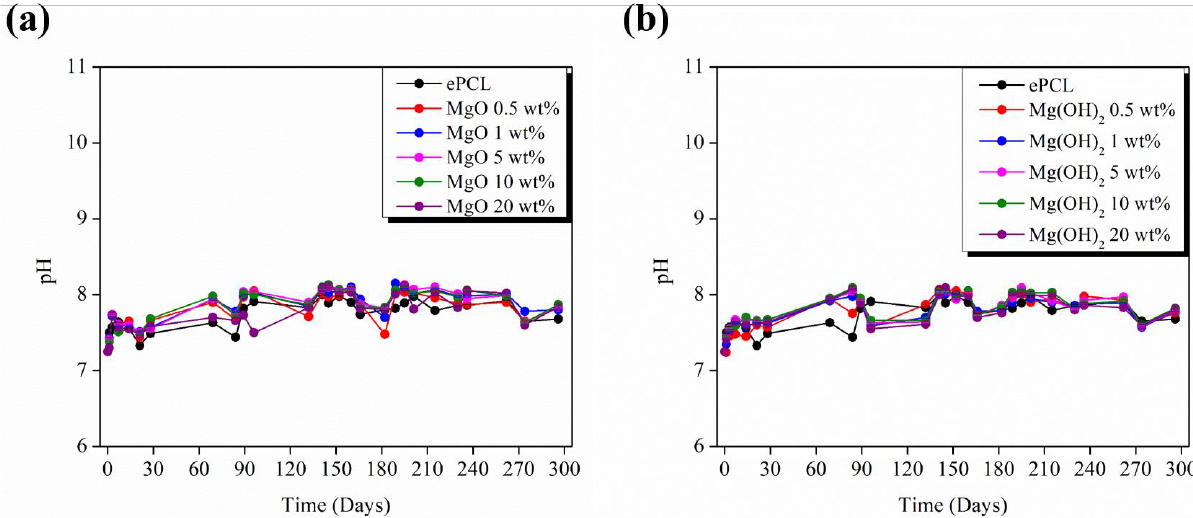
Figure 10. Variation of pH with time ( a ) ePCL + MgO NPs, ( b ) ePCL + Mg(OH) 2